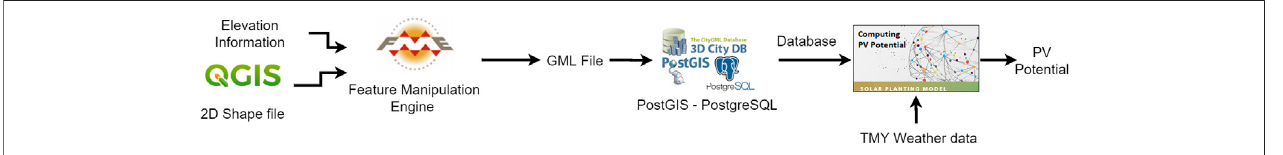
FIGURE 10 | Work fl ow of the PV generation potential estimation.